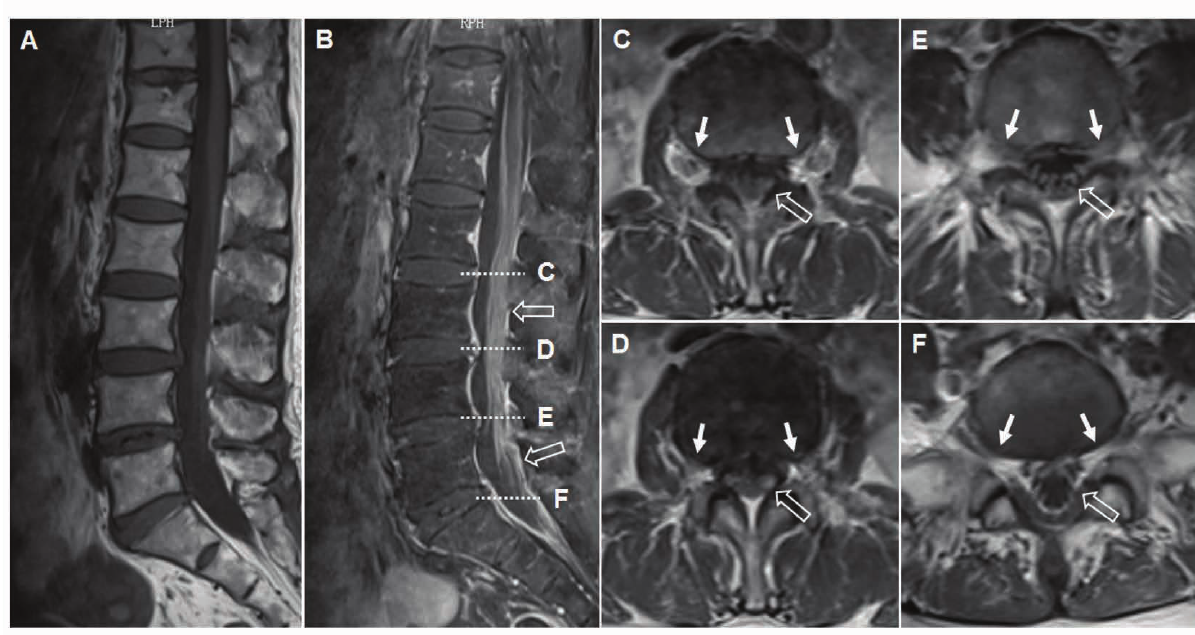
Figure 2: Lumbar magnetic resonance imaging (MRI) results of a 76-year-old woman with Guillain-Barré syndrome. Pre-contrast sagittal SE T1-weighted MRI demonstrated no abnormality of the cauda equina, conus medullaris, and dural sac (A). Contrast-enhanced fat suppressed sagittal T1-weighted MRI (B) and contrast-enhanced axial T1-weighted MRI (C-F) shows moderate to marked enhancement of the nerve roots (solid arrows) and cauda equina (open arrows). The levels of figures C-F were shown as the dotted lines in figure